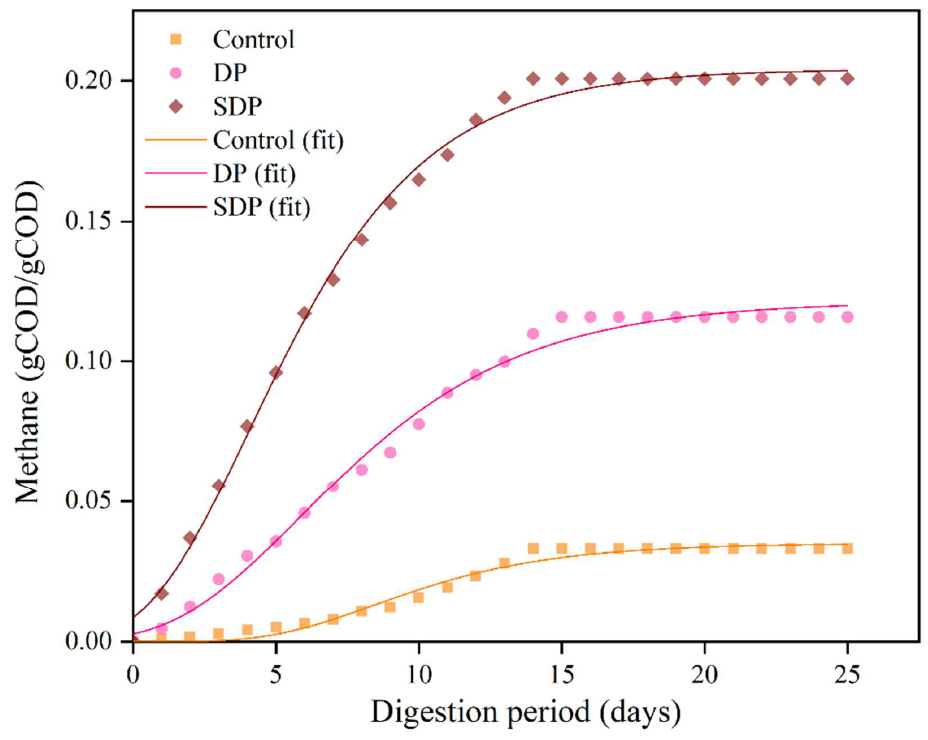
Figure 7. Methane production in various samples.